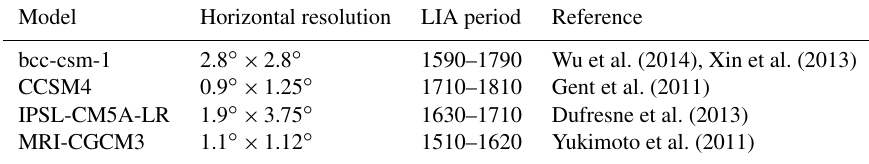
Table 1. Characteristics and definition of the LIA period for each model simulation used. Modified from Rojas et al.